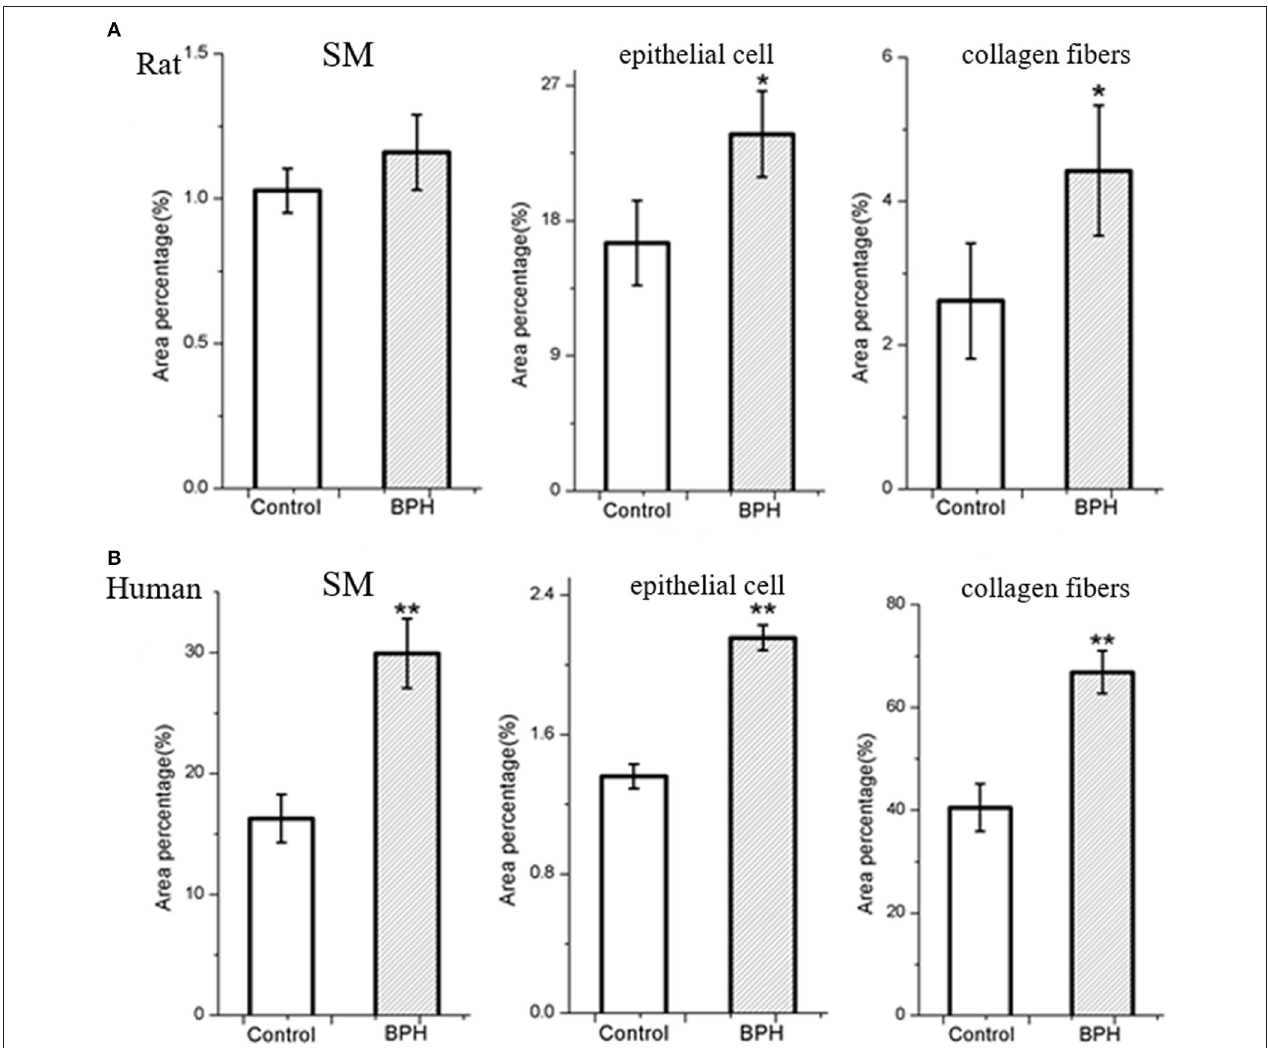
FIGURE 4 | Area percentage of different components in normal and BPH group. The percentage of each component was quantified from three random 100 × fields of each tissue slice ( n = 9 from each group). (A) Rat prostate. (B) Human prostate. Boxes, mean; bars, ± S.E.M; ** P < 0.01 vs. control; * P < 0.05 vs.